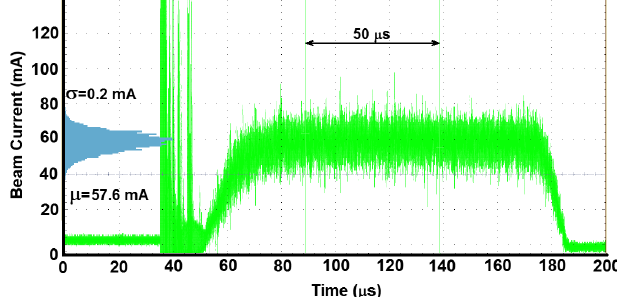
FIG. 15. Scope picture of the beam current signal from the toroid downstream of the source. Beam extracted at − 35 kV. Horizontal and vertical scales are 20 μ s = div and 10 mV = div, respectively.